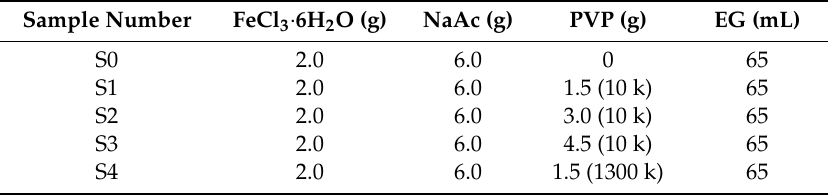
Table 1. Recipes for the synthesis of PVP-coated Fe 3 O 4